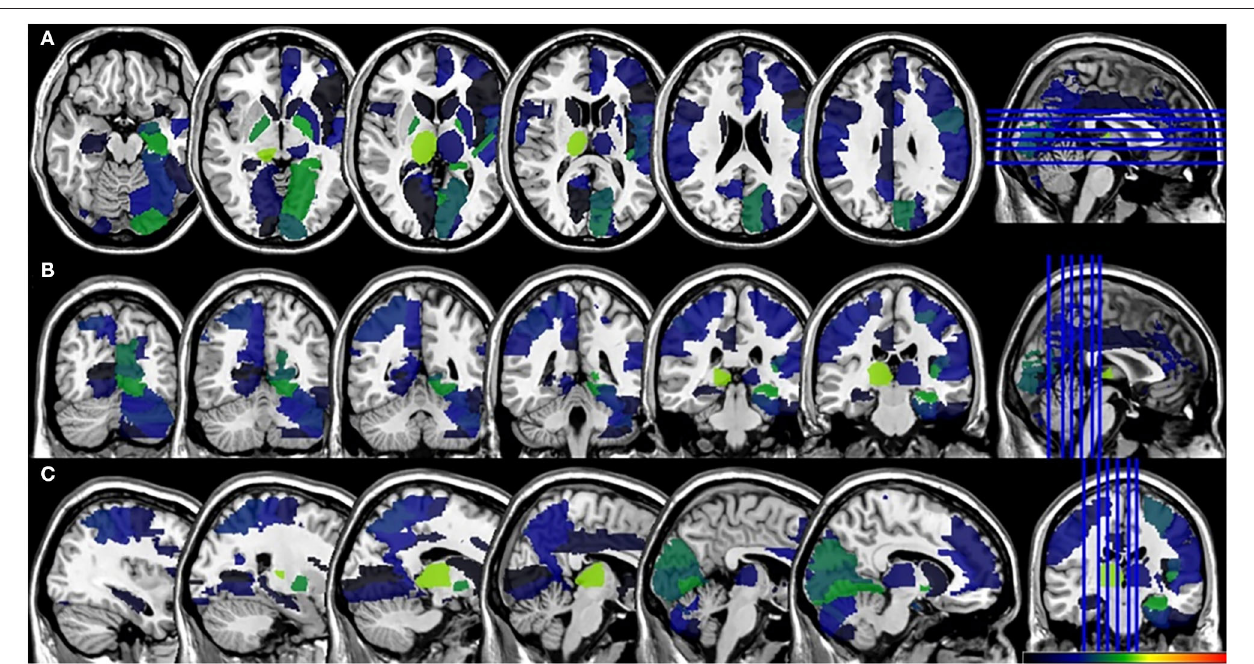
FIGURE 4 | VLSM results for poststroke fatigue at 6-month follow-up. (A) axial plane, (B) coronal plane, and (C) sagital plane. VLSM, voxel-based lesion-symptom mapping.